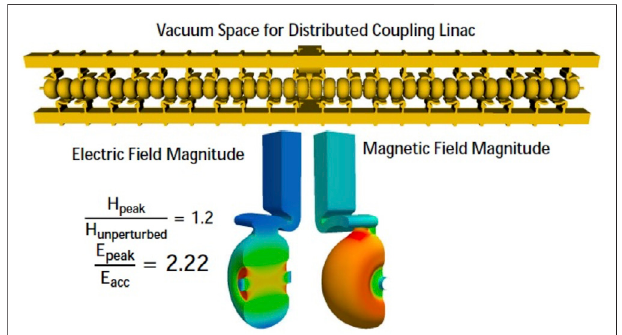
FIGURE 6 | Top: C 3 accelerating structure. Bottom: 3D model of a 1-m- long 40-cell C-band accelerating structure operating in the π mode. The magnitude of the electric and magnetic fi eld in each cell. The peak surface electric fi eldtoacceleratinggradient ratiois2.22. Theperturbation tothe magnetic fi eld from the RF coupler increases the peak magnetic fi eld by 1.2